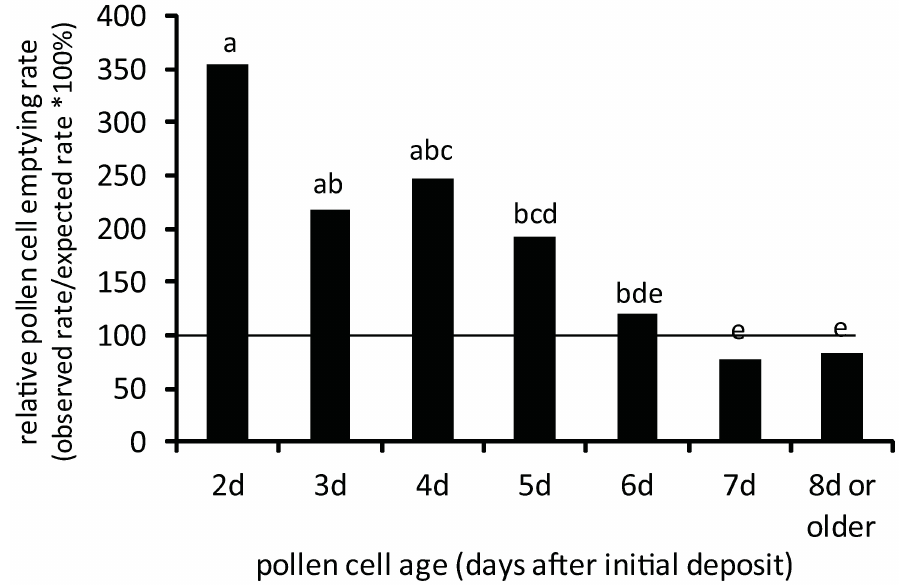
Fig 3. Relative pollen cell emptying rate (RPCER) of different-aged stored pollen cells from colony framesduring the last observation interval. For each pollen-ageclass, the observednumbersof emptied and unemptied cells was comparedagainst the numbers expectedby pollen-ageclass abundanceand overall emptyingrate alone.Pollen-ageclasses sharing the same superscript did not significantly differ in their relativeproportionsof emptiedand unemptied pollencells as determinedby post-hoc pairwisecomparisons (chi-square test of independence, Χ 2 total > 9.323, df = 1, p < 0.00238(Bonferroni-corrected significancelevel)).